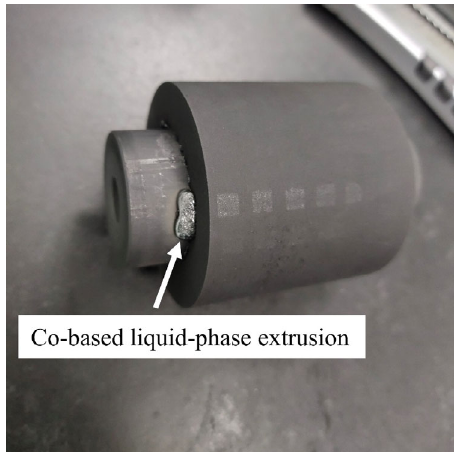
Fig. 2 Illustration of the Co phase extrusion during the SPS